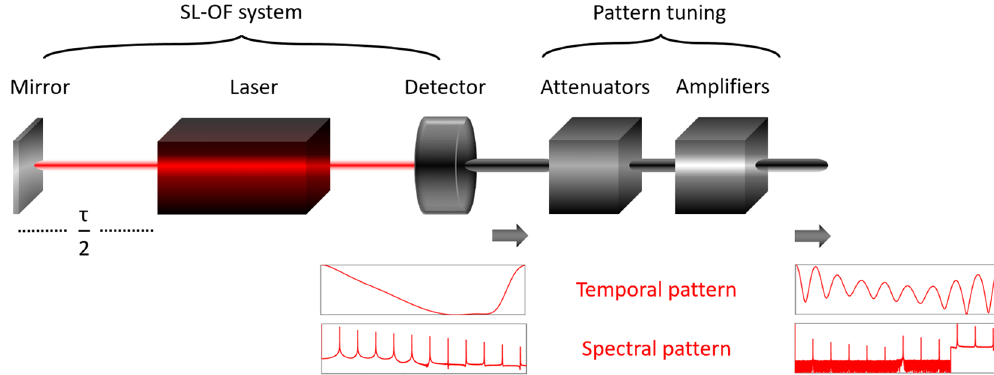
Figure 1. SL-OF system with external cavity round-trip time τ for generation of fast repetitive patterns with tunable intra-pattern structures. A set of microwave attenuators and amplifiers acting at different spectral regimes is used to tune the spectral profile and consequently the temporal pattern of the emitted